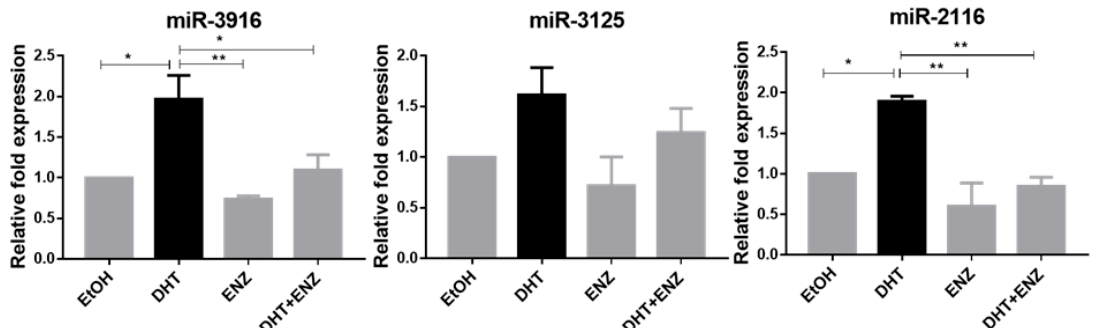
Figure 7. Expression of miR-3916, miR-3125 and miR-2116 in androgen- and anti-androgen-treated LNCaP cells. LNCaP cells were treated with 10 nM of androgen (DHT) and 10 µ M of enzalutamide (ENZ) for 48 h. miR-3916 and miR-2116 expression was upregulated with androgen treatment and suppressed with anti-androgen (enzalutamide) treatment. Statistically significant differences were assessed using a one-way ANOVA with Tukey’s multiple comparison test; data presented are mean ± SEM, n = 3, ** p < 0.01, * p < 0.05.